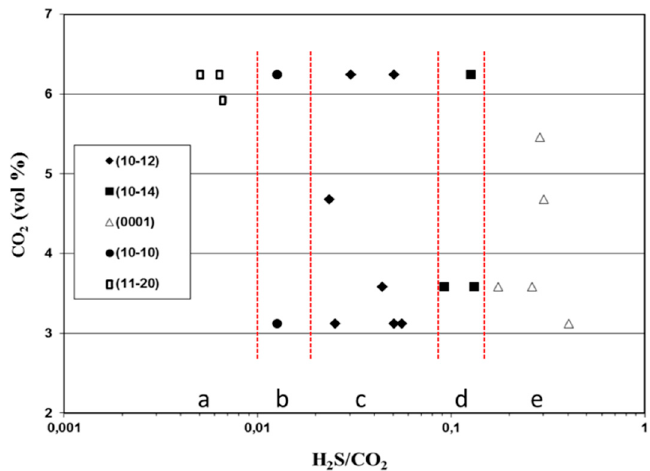
Figure 4. XRD results α -Al 2 O 3 showing the obtained textures plotted as a function of H 2 S/CO 2 ratio and CO 2 concentration (3.25 < CO 2 < 6.25). Process windows for (11 2